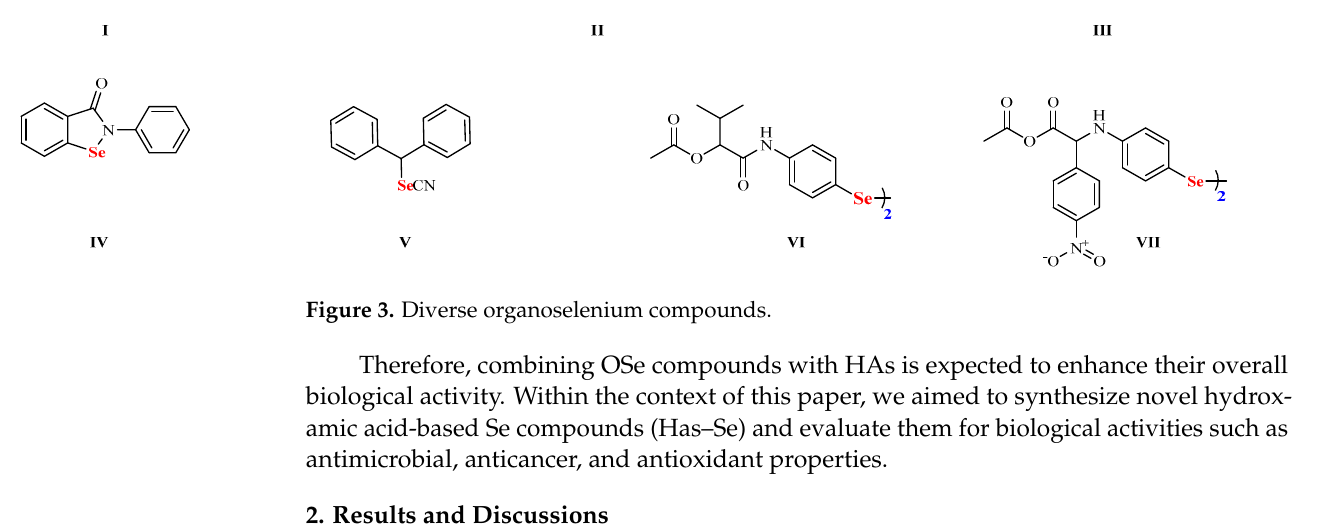
Figure 3. Diverse organoselenium